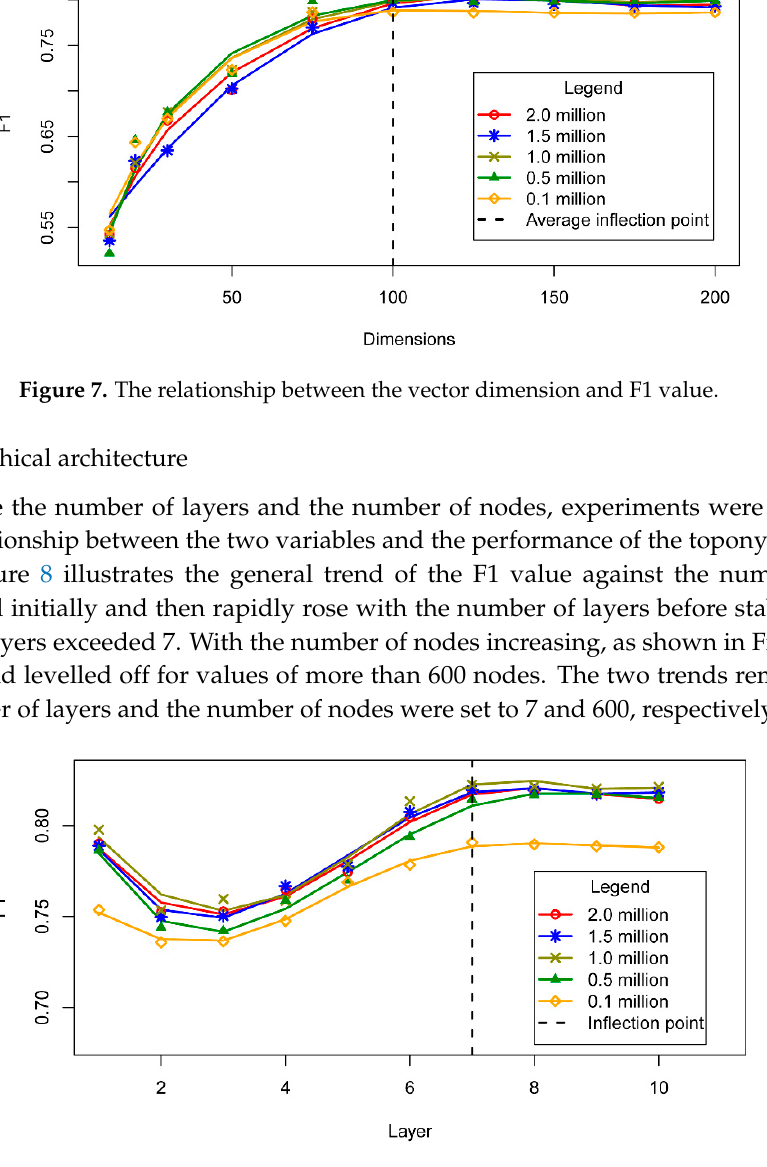
Figure 8. The relationship between the number of layers and F1 values.